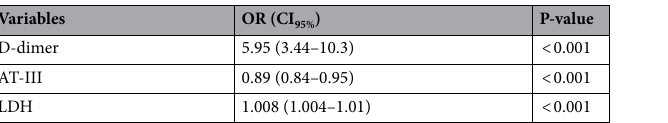
Table 5. Final binary logistic regression analysis of predictor variables of severe illness. LDH lactate dehydrogenase, ATT-III antithrombin-III. *Statistically